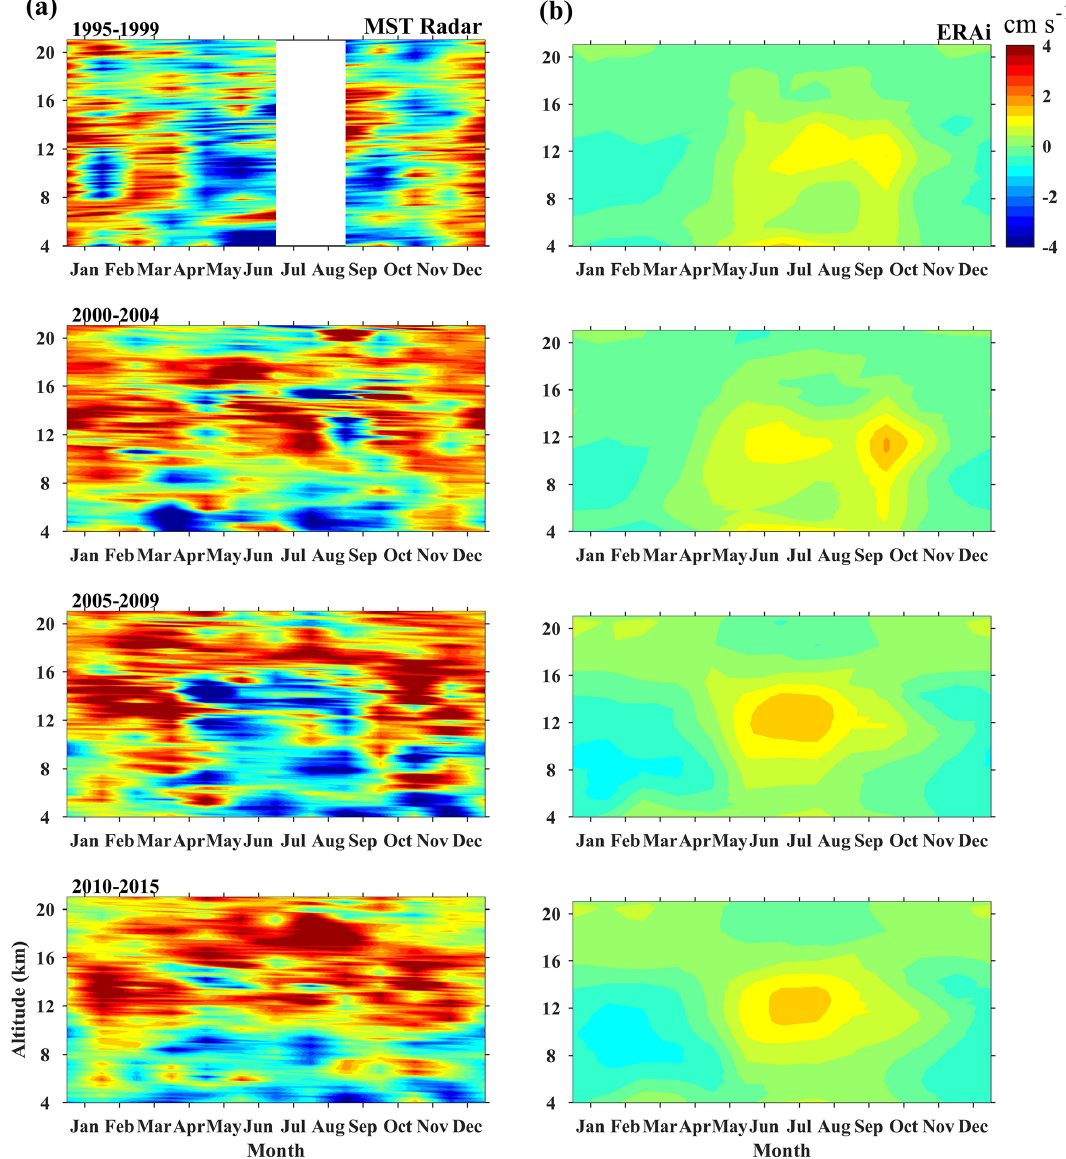
Figure 6. Monthly mean w obtained from (a) IMSTR and (b) ERAi for a 5-year interval (from top to bottom) over Gadanki (12:00UTC).